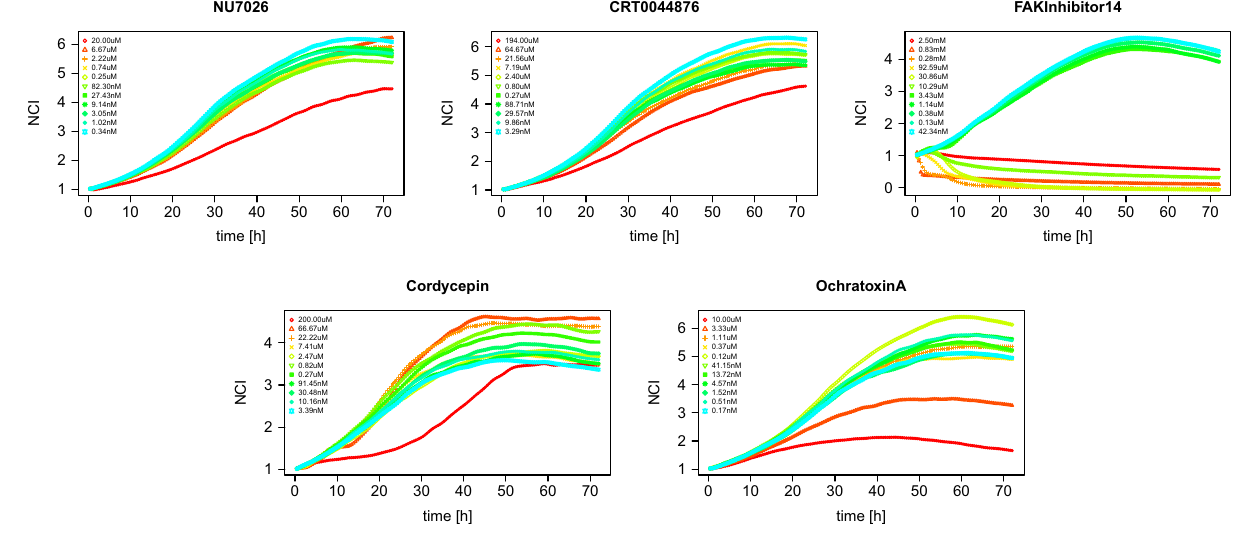
Figure 9. The five chemicals that defy all clustering